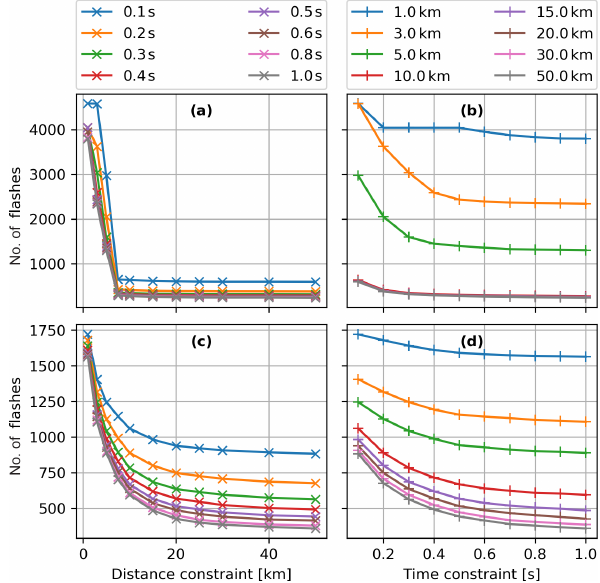
Figure 2. Total flash number based on constant, equal time con- straint d t merge (line color) with varying distance d s merge for ele- ments of ISS-LIS (a) and Meteorage (c) flashes. Panels (b) and (d) are with constant, equal distance d s merge (line color) and vary- ing d t merge for ISS-LIS and Meteorage,